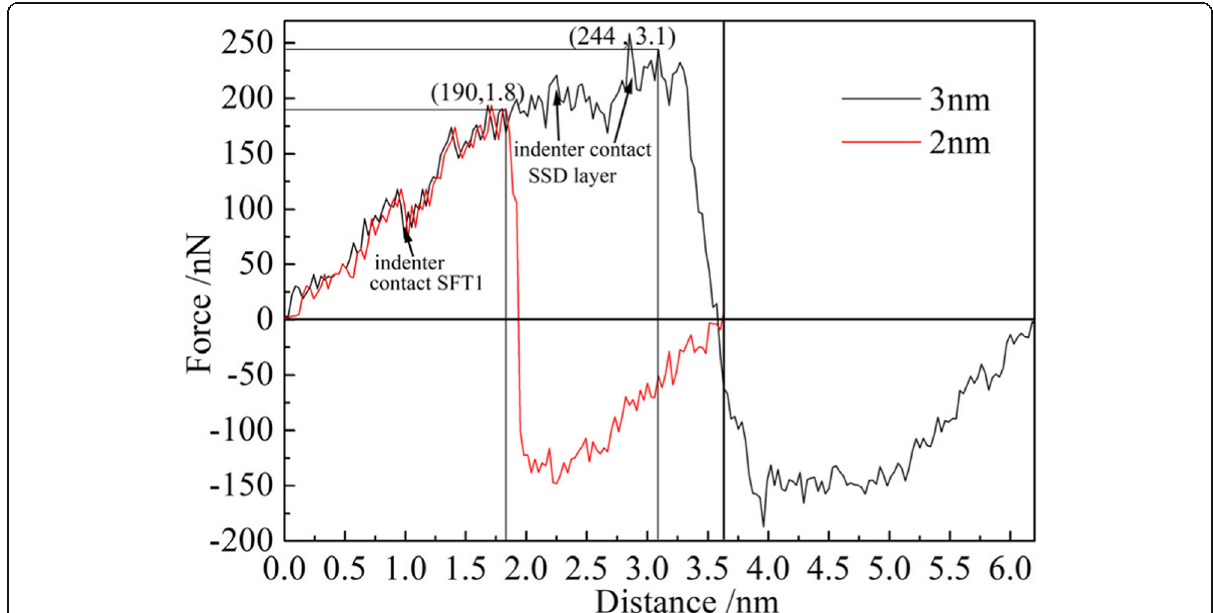
Fig. 11 Load-displacement curve of nano-indentation on the machining-induced specimen (color online). The maximum indentation depth of the black curve and the red curve respectively is 3 nm and 2